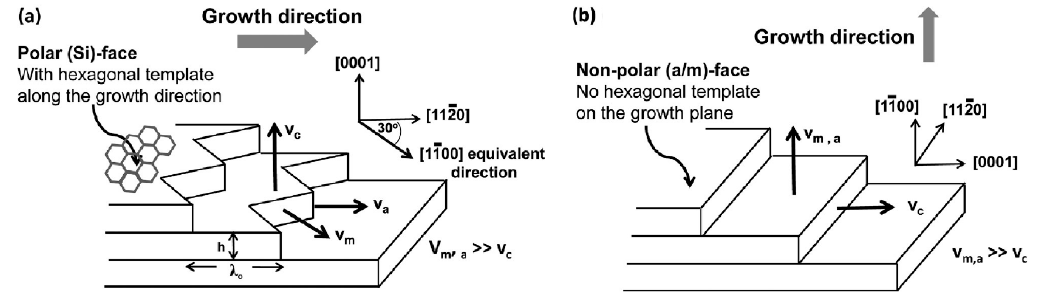
Figure 37. Graphene growth mechanism on ( a ) the polar (Si) face SiC with offcut toward [11 0] and ( b ) the nonpolar a/m face with slight offcut along [0001]. The EG growth on the polar face proceeds laterally while the EG growth on the nonpolar face is limited by the vertical growth rate. The zigzag structure shown on the polar face step edge is a consequence of two possible lateral growth directions [110].